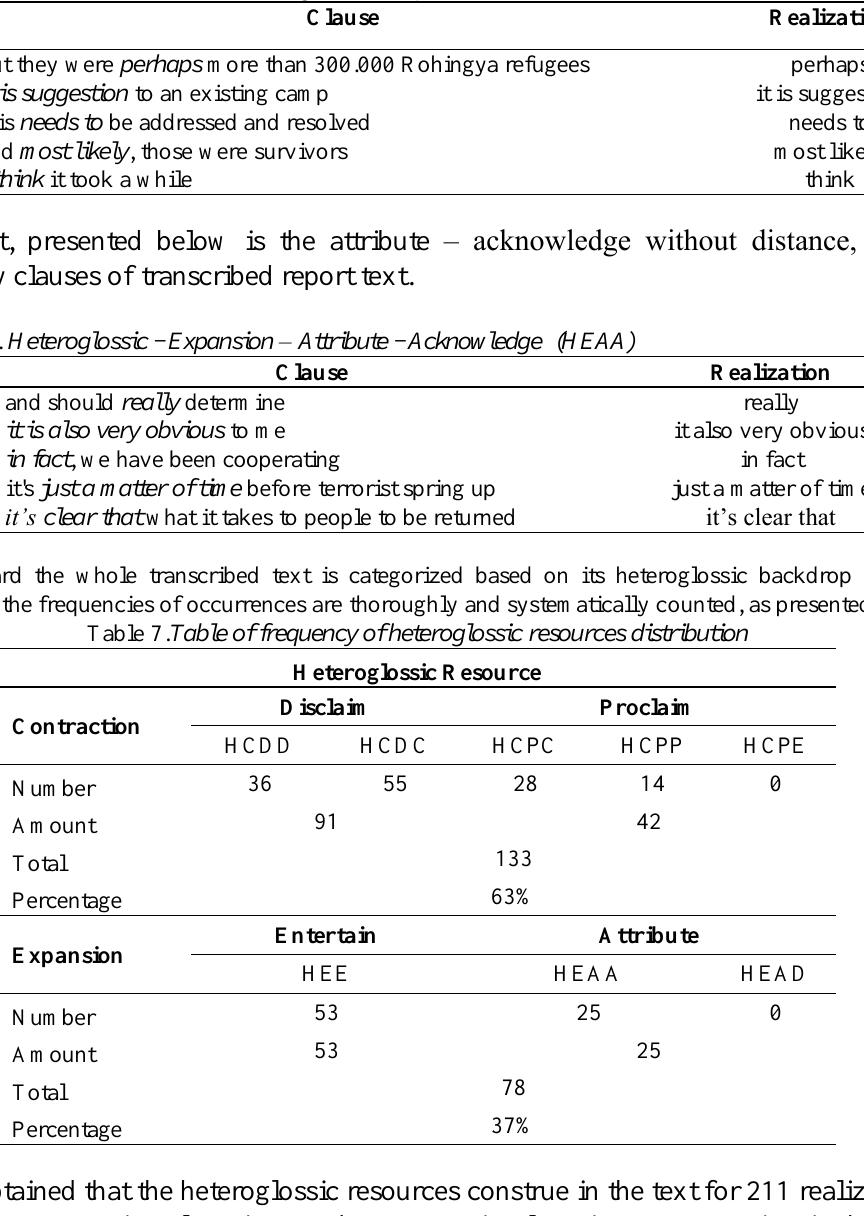
Table 5. Heteroglossic - Expansion – Entertain (HEE)